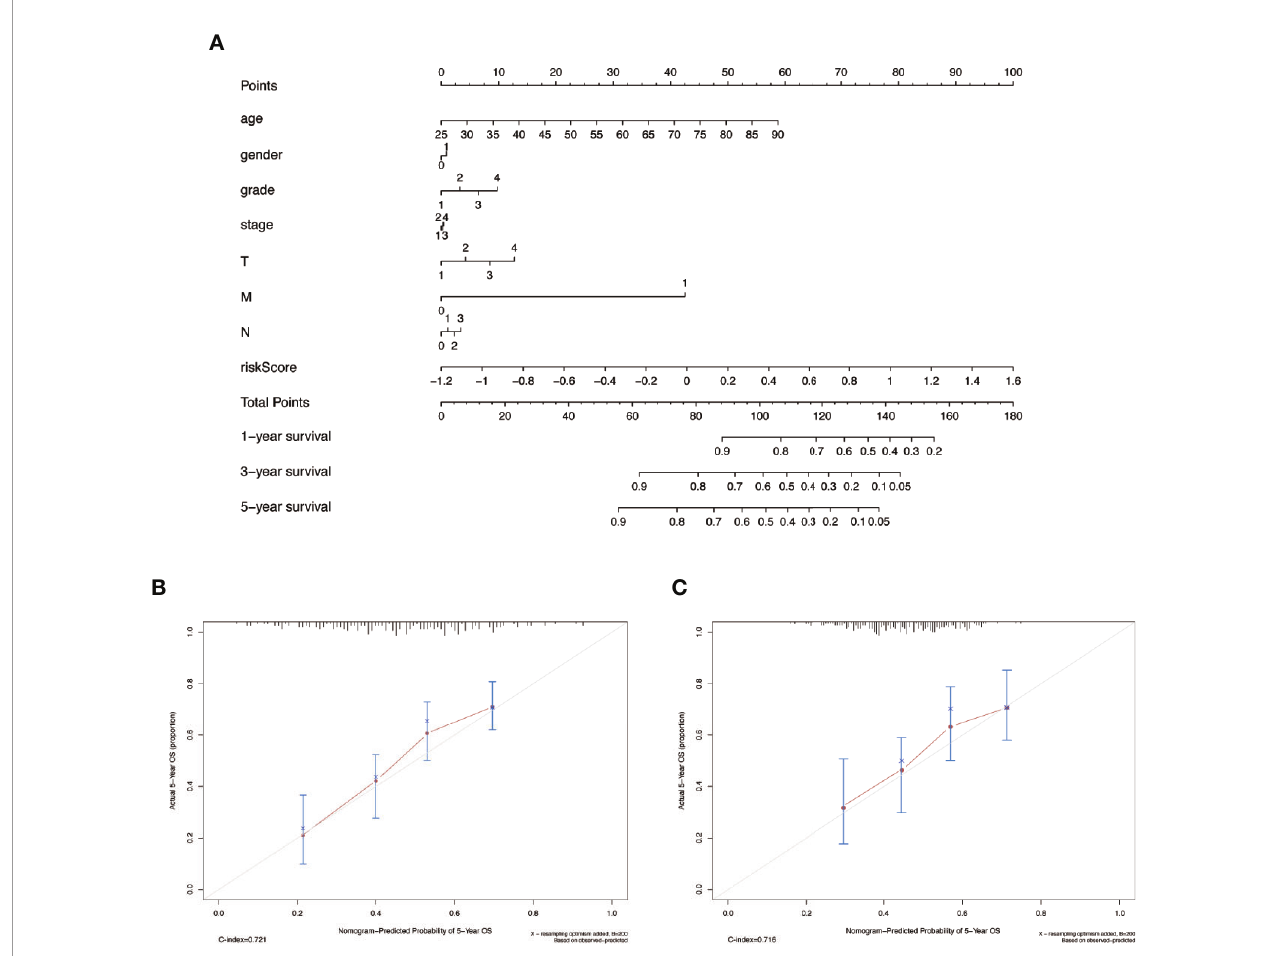
FIGURE 8 | The nomogram to anticipate prognostic probabilities in HNSCC dataset. (A) The nomogram for predicting OS development in the training dataset. (B, C) The calibration plots for predicting 5-year in the training dataset and validation dataset. Notes: The x-axis and y-axis represent nomogram predicted and actual survival, respectively. The solid line indicates the predicted nomogram, and the vertical bars represent a 95% con fi dence interval.